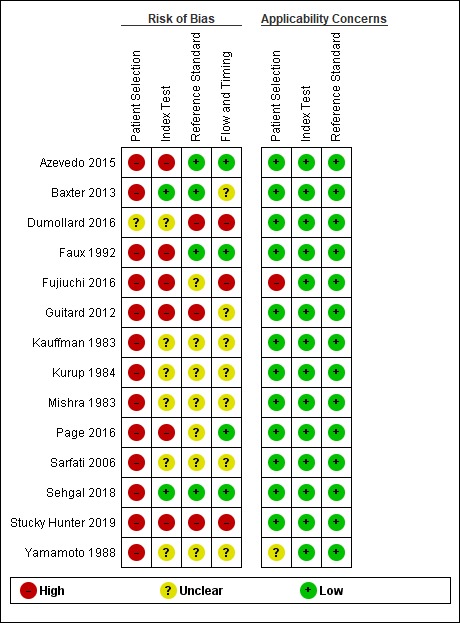
Risk of bias and applicability concerns graph: Review of the authors’ judgments about each domain presented as percentages across included studies.